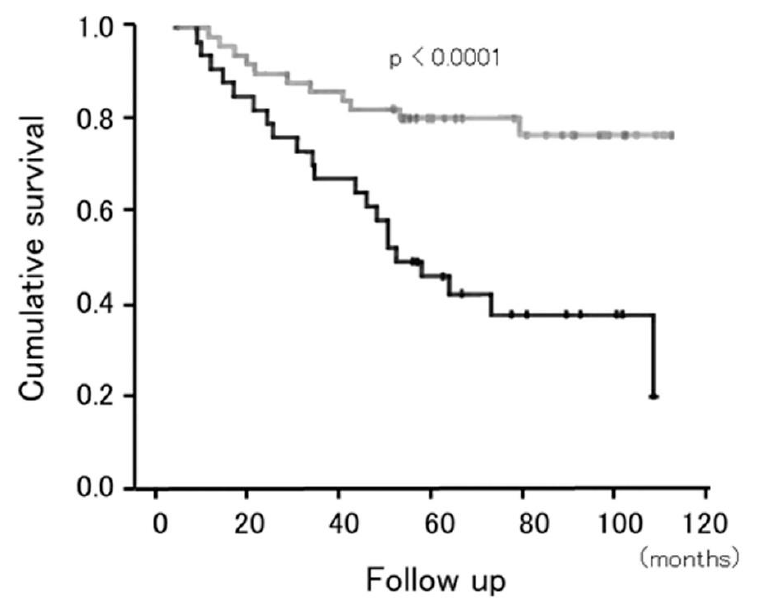
Figure 4. Cumulative survival according to the sedentary time. Survival rate in patients with COPD after adjusted by sex, age, body mass index, educational level, lung function, functional exercise capacity, and moderate to vigorous-intensity physical activity. Gray line indicates the patients with < 8.5 h / day of time spent in sedentary activities. Black line indicates the patients with ≥ 8.5 h / day of time spent in sedentary activities. Adopted from [101].